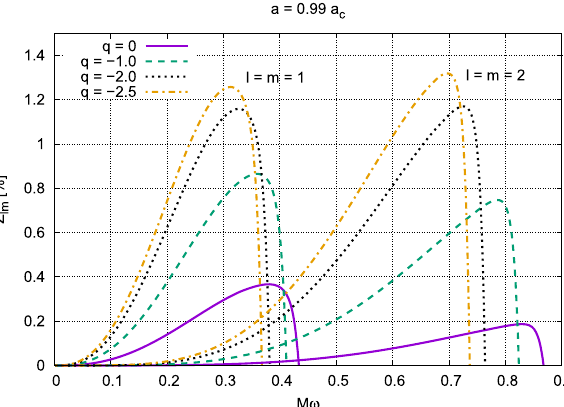
Fig. 5 Amplification factors for a = 0 . 99 a c in the cases q = 0 , − 0 . 5 , − 1 for l = m = 1 (top) and l = m = 2 (bottom). In terms of the black hole mass a / a c = 0 . 99 means a / M ≈ 1 . 21 , 1 . 40 for q = − 0 . 5 , − 1 respectively